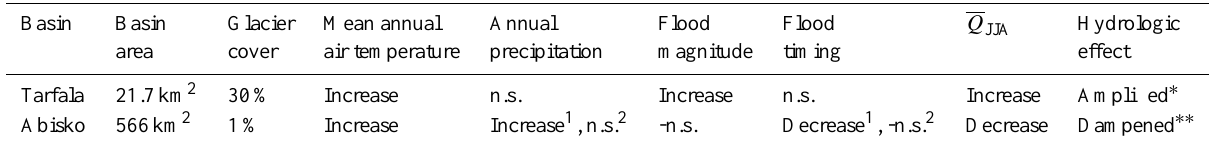
Table 8. Summary of trends observed in the Swedish Tarfala and Abisko catchments. Streamflow dynamics and flood events in northern landscapes are typically driven by either snowmelt (thermally driven) in the spring or the occurrence of precipitation events during the late summer and